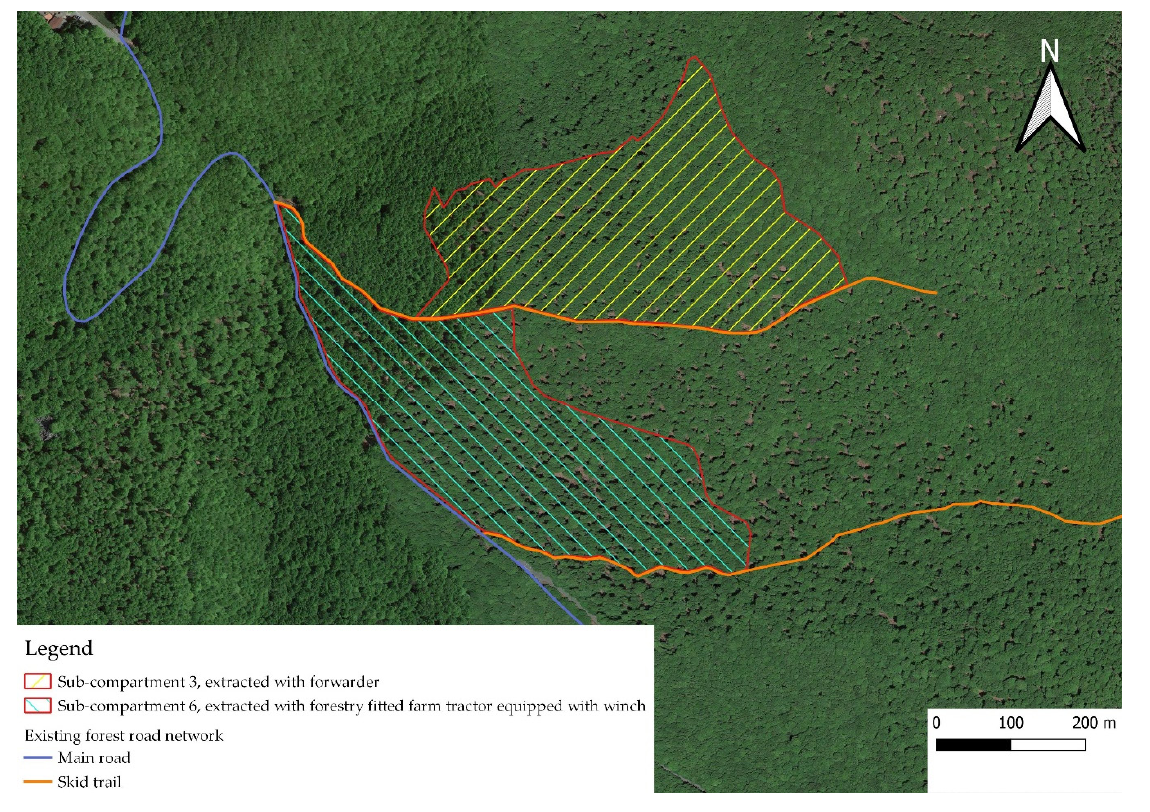
Figure 1. Study area. The boundaries of the two subcompartments are reported in red. The parcel extracted with a forwarder has yellow lines, while the one in which extraction was performed via winching has light blue lines. In the figure the existing road network before harvesting is shown. Blue line is for the main road, and the orange line is for the existing skid trails. Table 1. Technical features of the applied machineries for WINCH and FORW experimental treat- ments and main average operative data ( ±